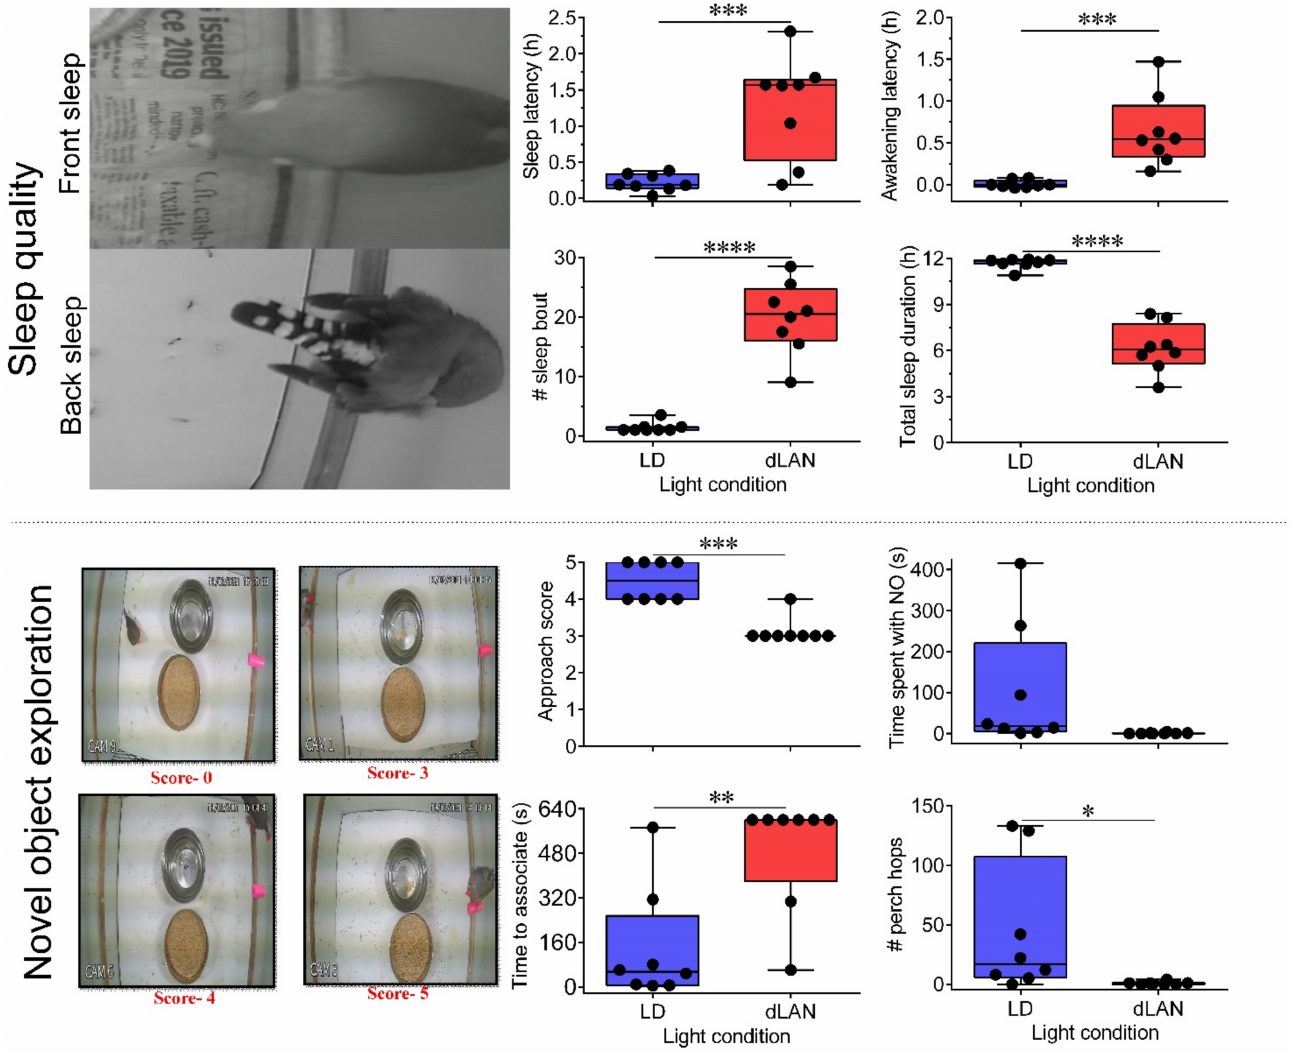
Figure 3. Sleep and novel object exploration behavior in adult male zebra finches ( Taeniopygia guttata ) under 12 h light: 12 h darkness (12L:12D) and 12 h light: 12 h dim light at night (12L:12dLAN) as described in Figure 1. The upper panel shows changes in the four different sleep parameters (sleep latency, awakening latency, numbers of sleep bout and total sleep duration) and photomicrographs showing front and back sleep. Lower panel shows the results of NOE test and scoring pattern based on bird’s position with respect to the novel object. Box-whisker plot represents the range of highest to lowest values. Black circle represents individual value. The * symbol shows significance tested by Student’s t -test, set at p < 0.05 (* p < 0.05, ** p < 0.01, *** p < 0.001, **** p <